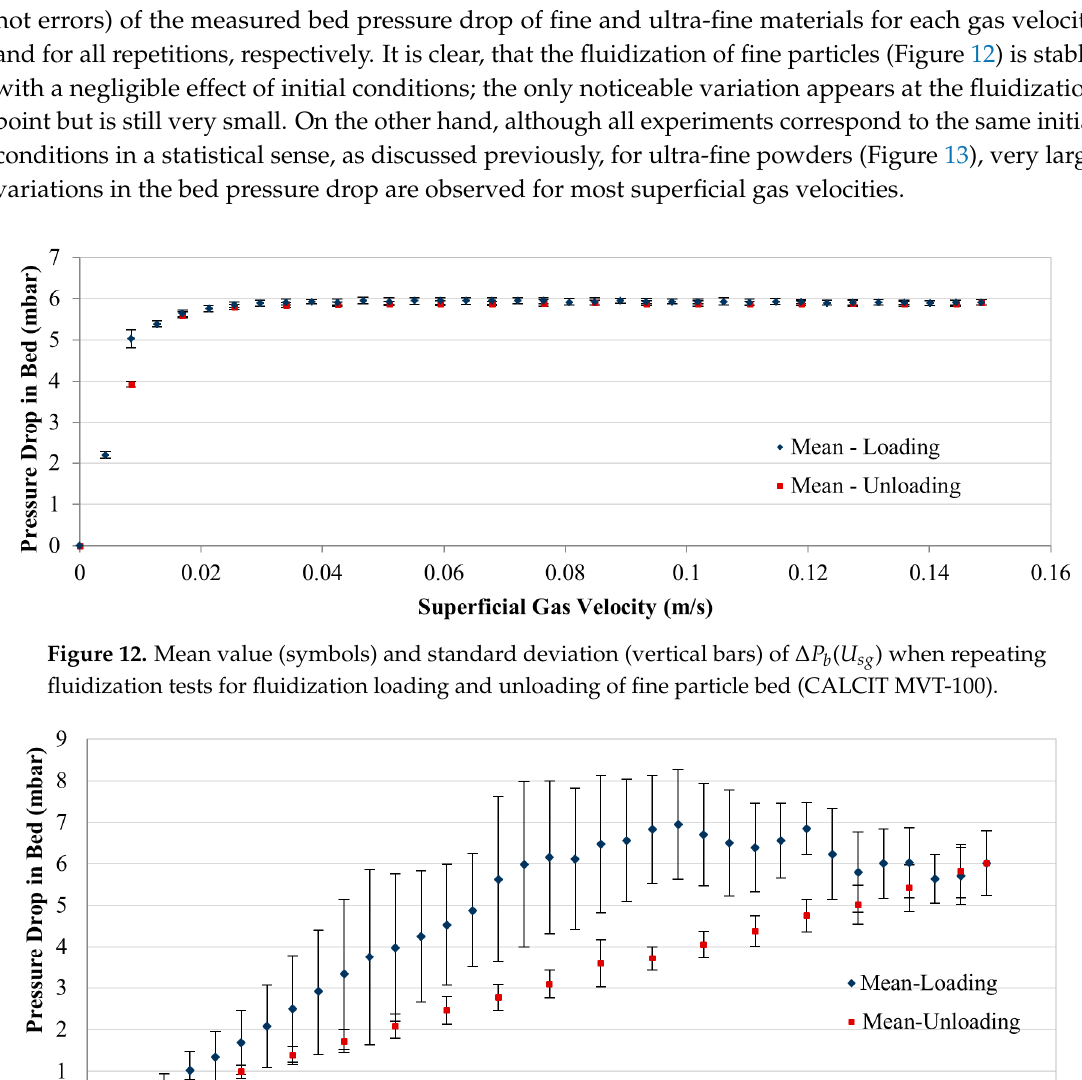
Figure 14. Mean value of ∆𝑃 (cid:3029) ( 𝑈 (cid:3046)(cid:3034) ) when repeating fluidization tests for fluidization loading and unloading of fine particle bed (CALCIT MVT-100).